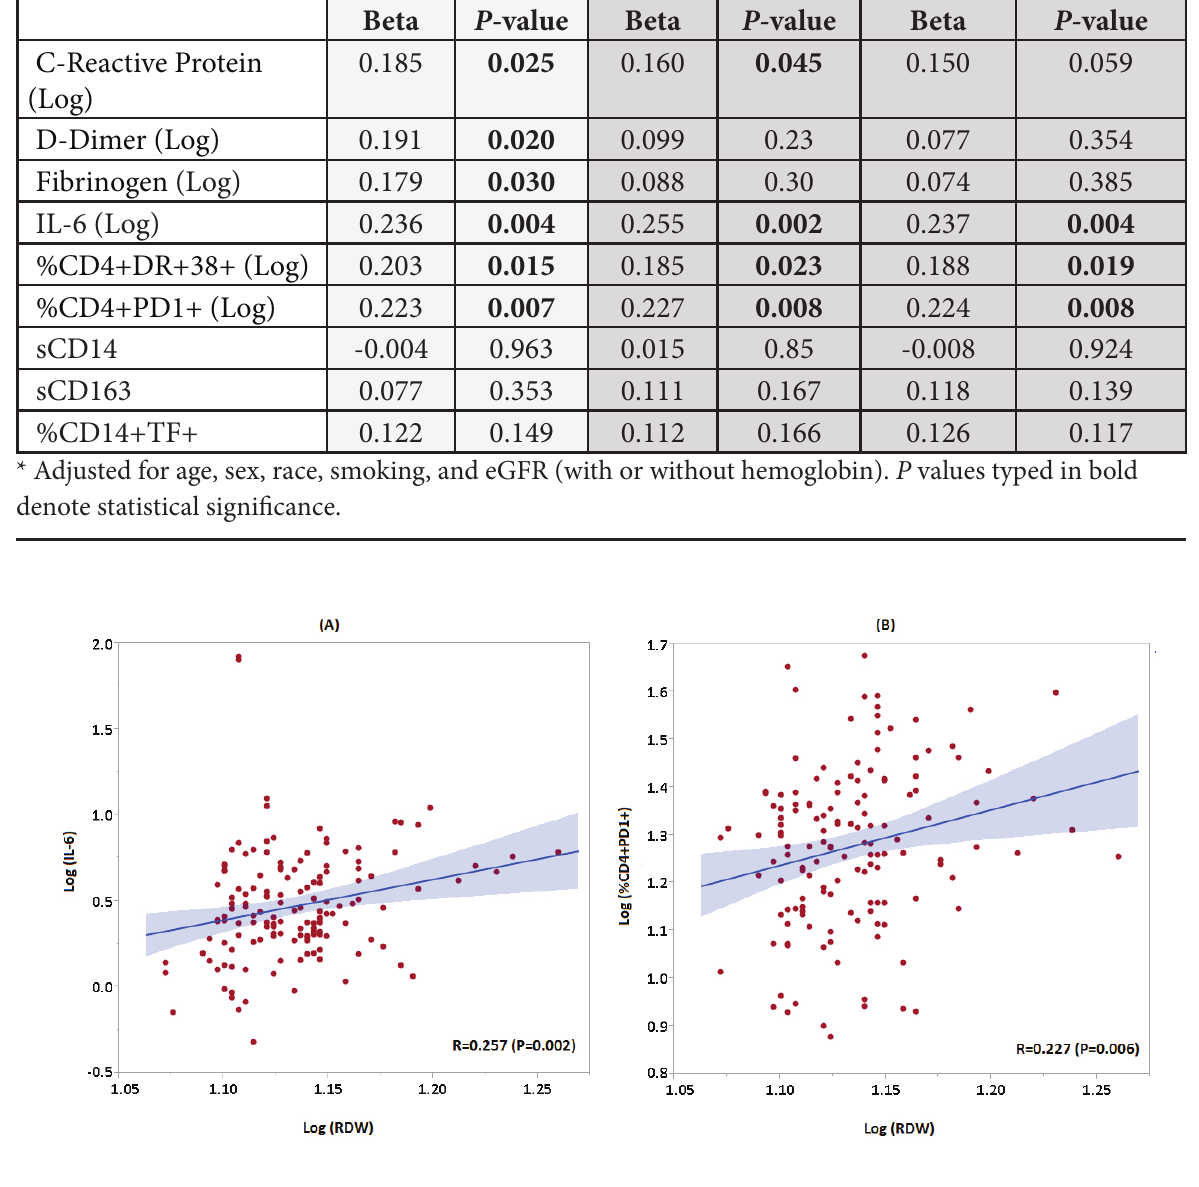
Figure 1. Scatter plots demonstrating the relationship between RDW and (A) log IL-6 and (B) log CD4+PD1+ T cells. Regression line with 95% CI displayed in